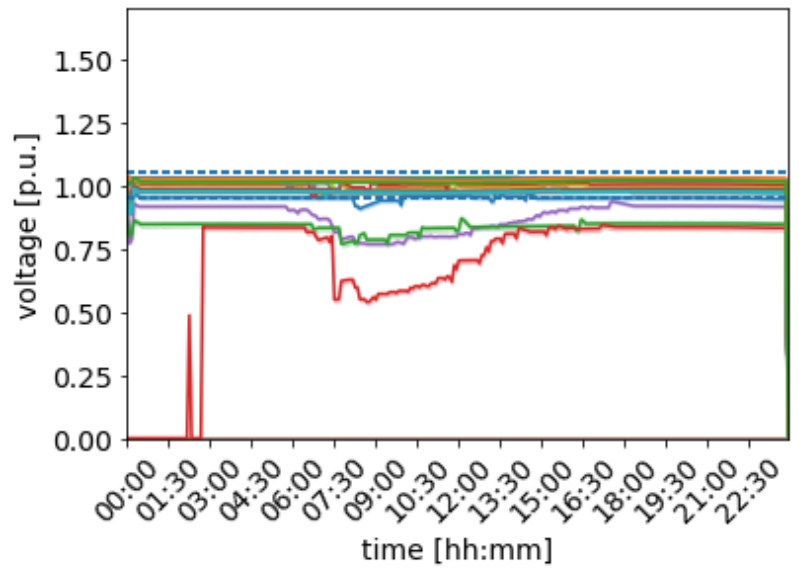
Figure 13. Scenario 3 distribution feeder nodal voltage mean and 95% range for all nodes, plotted by substation feeder group .